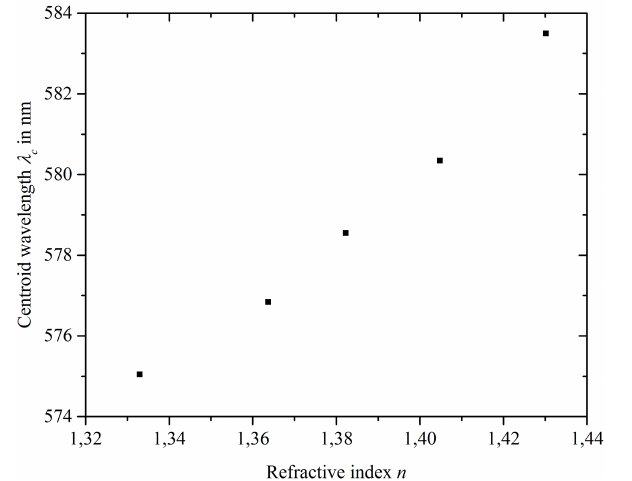
Figure 7. Centroid wavelength of the normalized reflection spectra from Fig. 6.